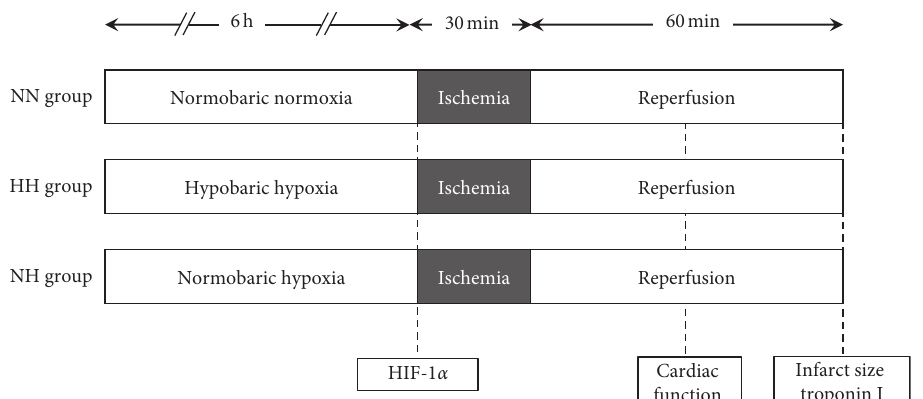
Figure 1: Experimental protocol. All rats were subjected to 30min of ligation of the left anterior descending artery (LAD) followed by 60min of